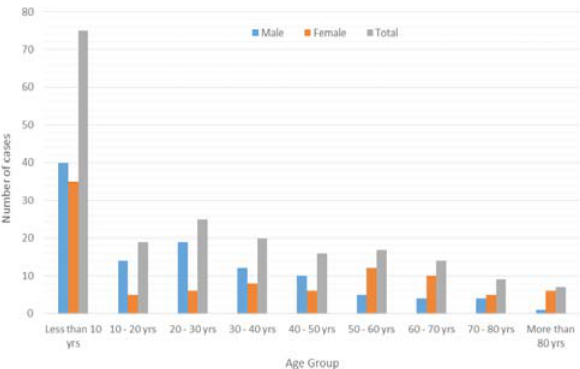
Figure 1. Patient distribution according to age